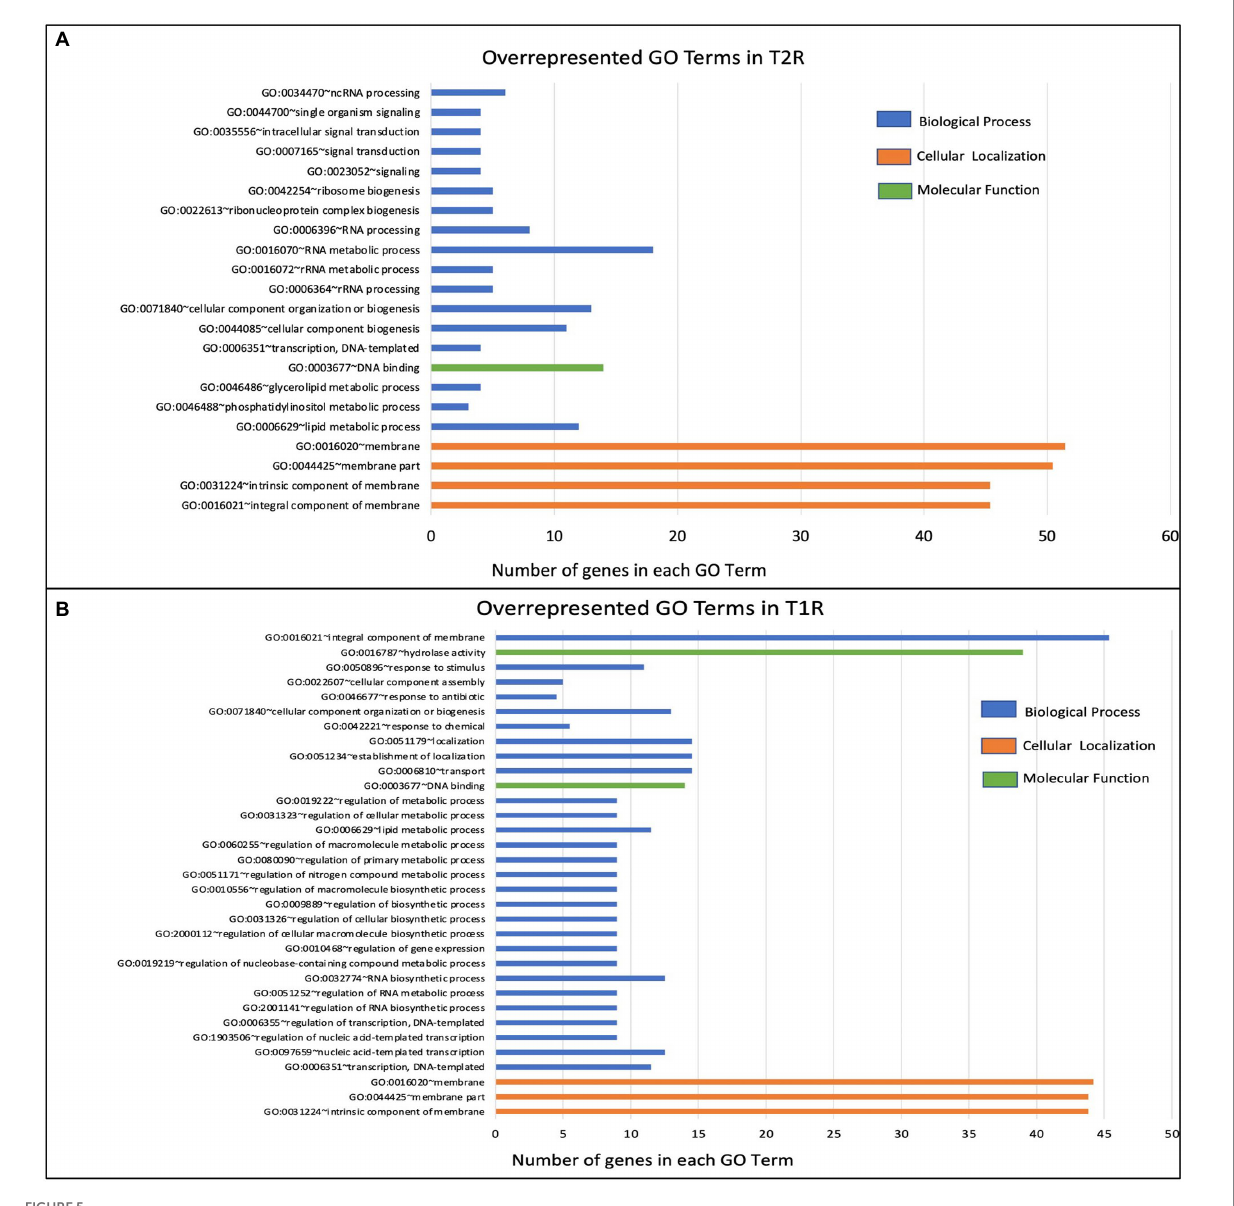
FIGURE 5 Over-represented GO terms in the T1R Group ( p < 0.05) in comparison to NR (A) and in the T2R Group ( p < 0.05) in comparison to NR group (B) . The number of genes on x -axis indicates genes that have the same GO term in each of the classes (biological process, cellular localization, and molecular